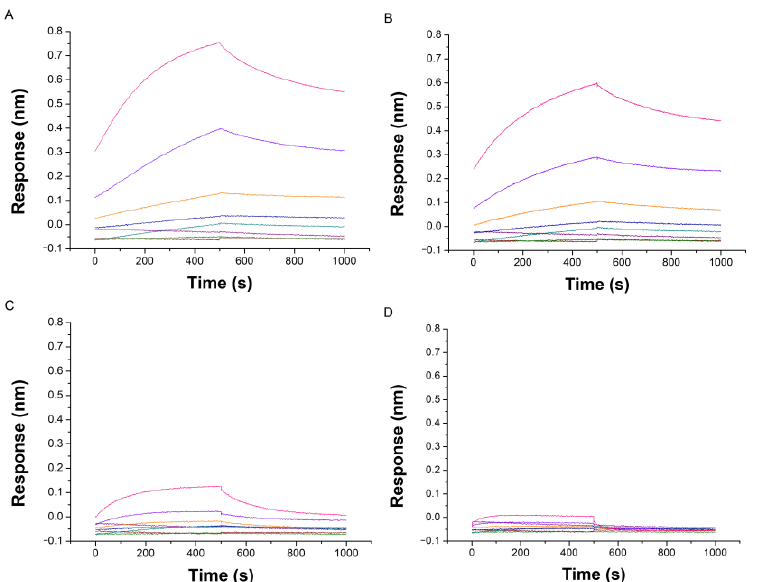
Figure 3. Sensorgrams recorded at pH 5.5 for the recognition of IMC-48 with immobilized sequences: ( A ) HRAS ; ( B ) bcl-2 ; ( C ) Htelo-C ; and ( D ) c-myc . Concentration range: 0.1 (blue), 0.5 (brown), 1 (green), 5 (dark cyan), 10 (black), 25 (orange), 50 (violet), and 100 µM (pink). Buffer composition: 50 mM TrisHCl, 50 mM KCl, 2% DMSO and 0.05% v/v surfactant P20.